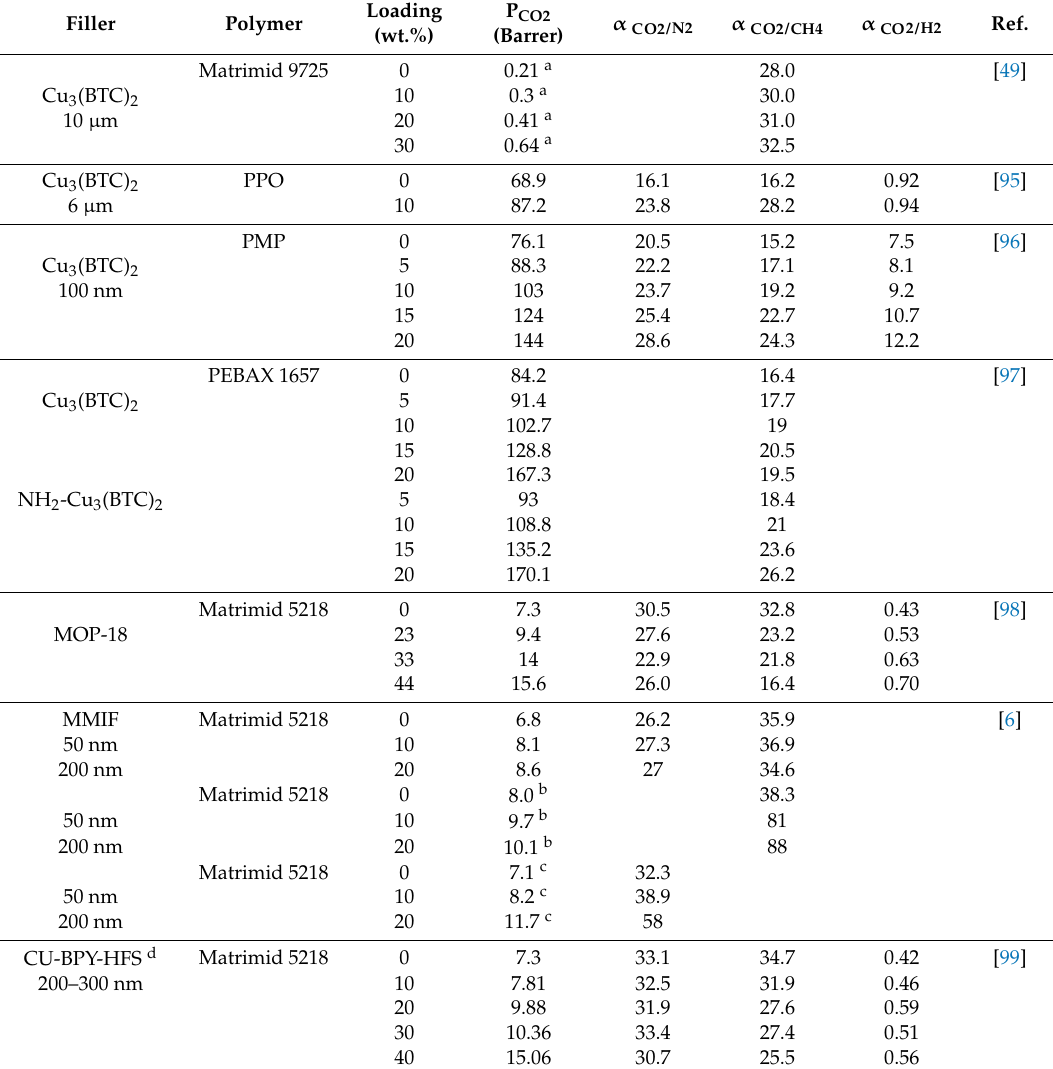
Table 3. Gas separation performance of Cu-based MOFs used to prepared mixed matrix membranes (operating conditions ranging within 1–5 bar, 20–35 ◦ C, unless differently specified). Loading P CO2 α Filler Polymer (wt.%) (Barrer)